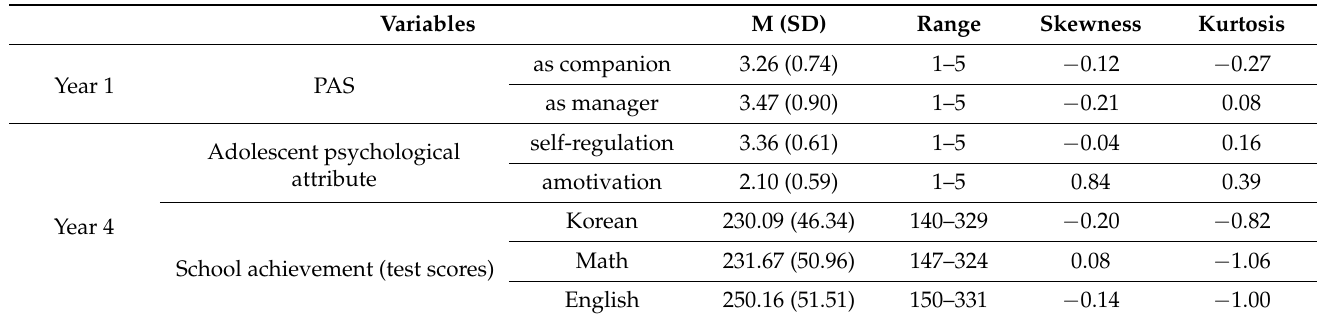
Table 2. Descriptive Statistics for the PAS, Adolescent Psychological Attribute and School Achievement.